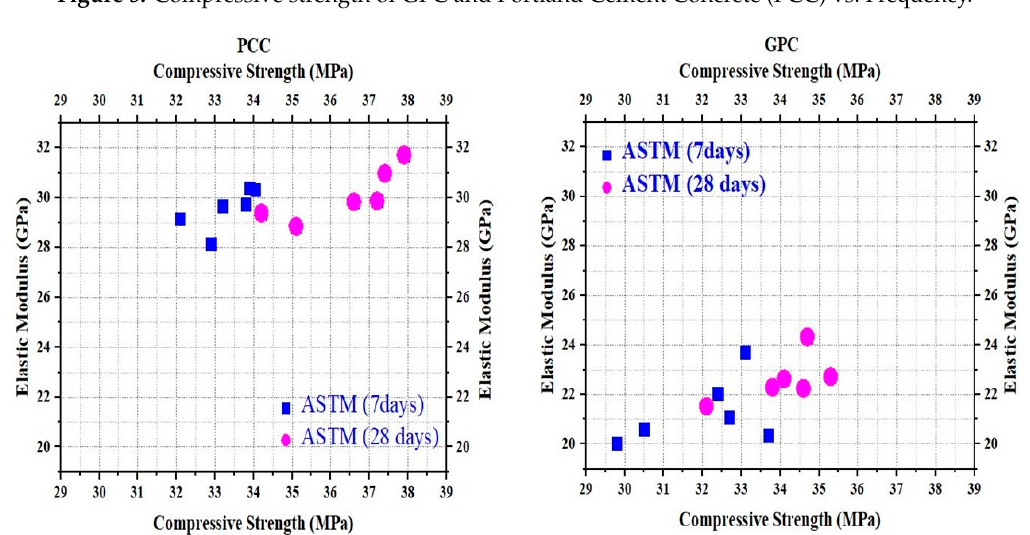
Figure 6. Elastic modulus versus compressive strength.